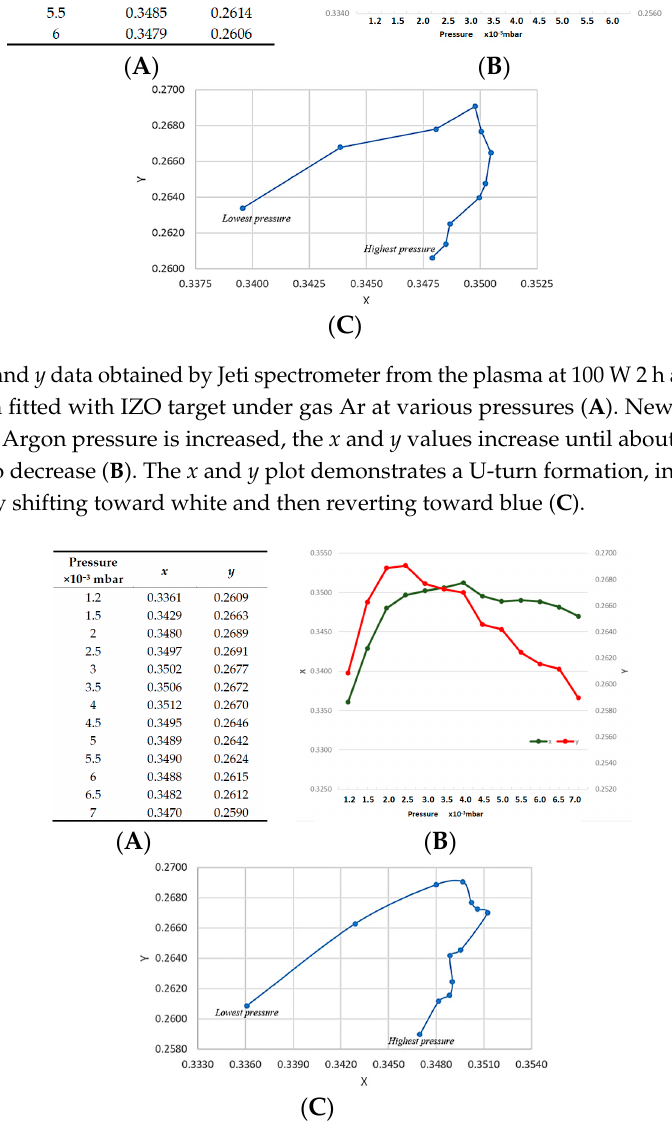
Figure 8. The x and y data obtained By Jeti spectrometer from the plasma at 100 W 2 h after stabilization for a magnetron fitted with IZO target under gas ArH at various pressures ( A ). As the Argon Hydrogen mix pressure is increased, the x and y values increase until about 2.5 × 10 − 3 mbar and then start to decrease ( B ). The x and y plot demonstrates a U-turn formation, indicating that the colour is initially shifting toward white and then reverting toward blue ( C ).